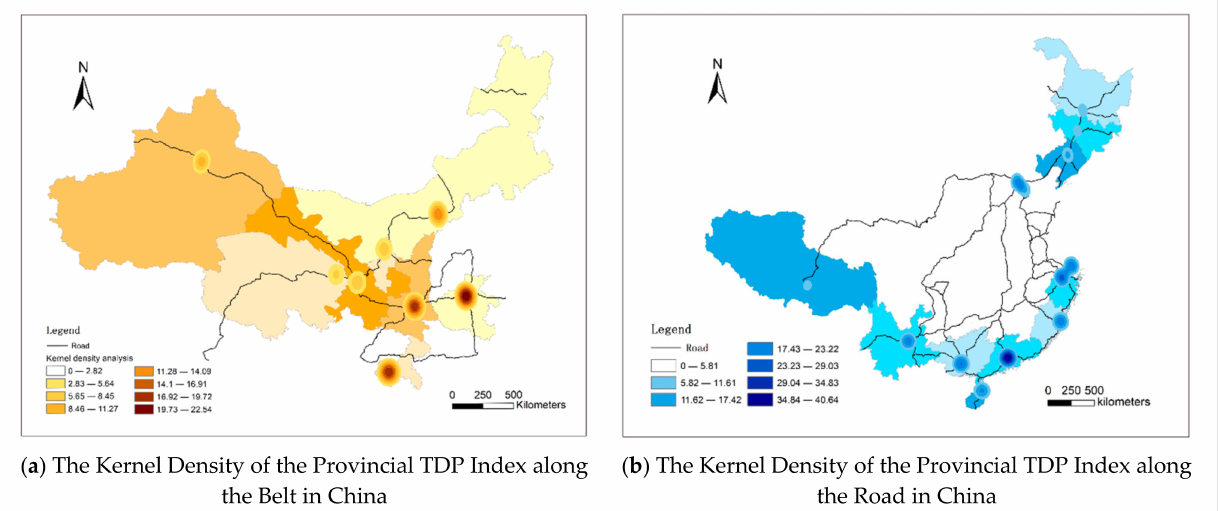
Figure 4. The kernel density of the provincial TDP index along the Belt and Road in